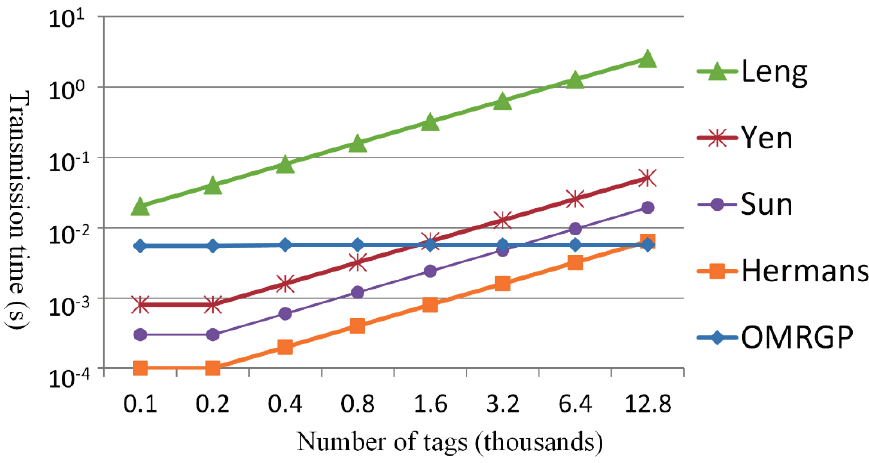
Figure 11. Comparing the message quantity transmitted by the